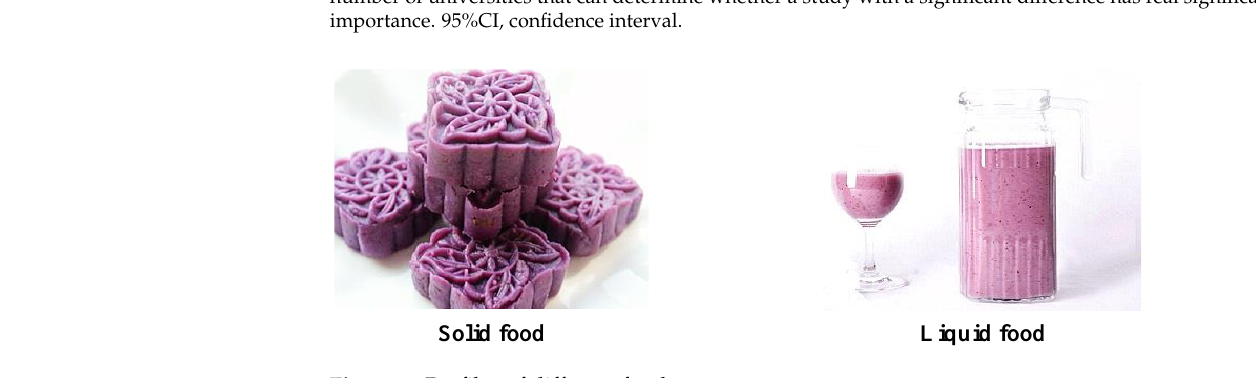
Figure 1. Profiles of different foods.